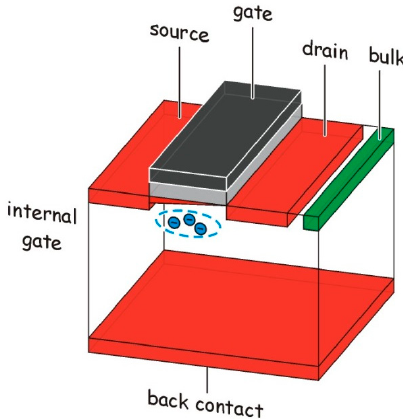
Figure 1. The concept of a DEPFET: The signal electrons are collected in a potential minimum (internal gate) located below the channel of a FET located on top of the fully depleted bulk.